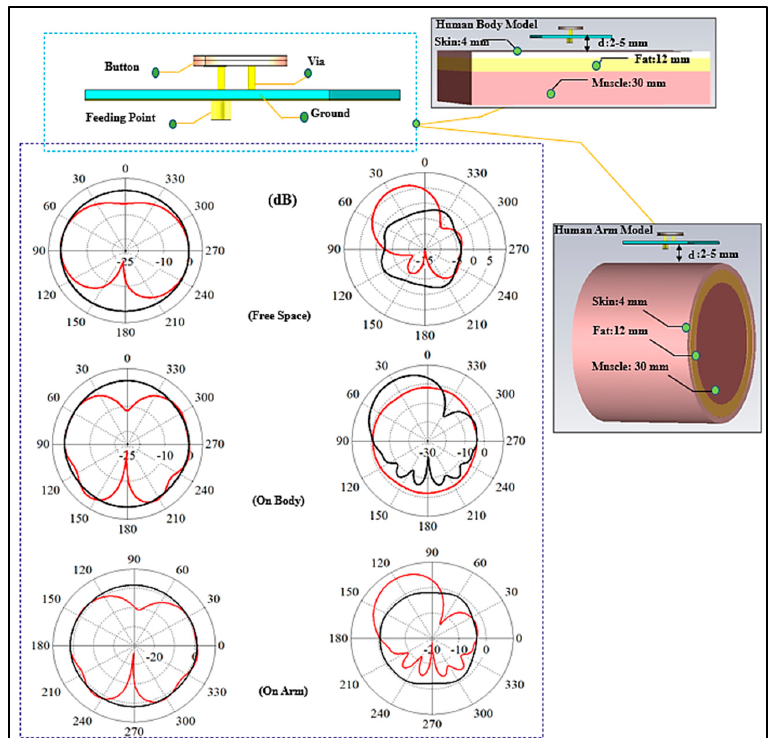
Figure 8. The reflection coefficient (S 11 ) of the BSA for different feed locations (lower band markers are at 2.22 to 2.8 GHz; upper band markers are at 5.0 to 5.9 GHz).